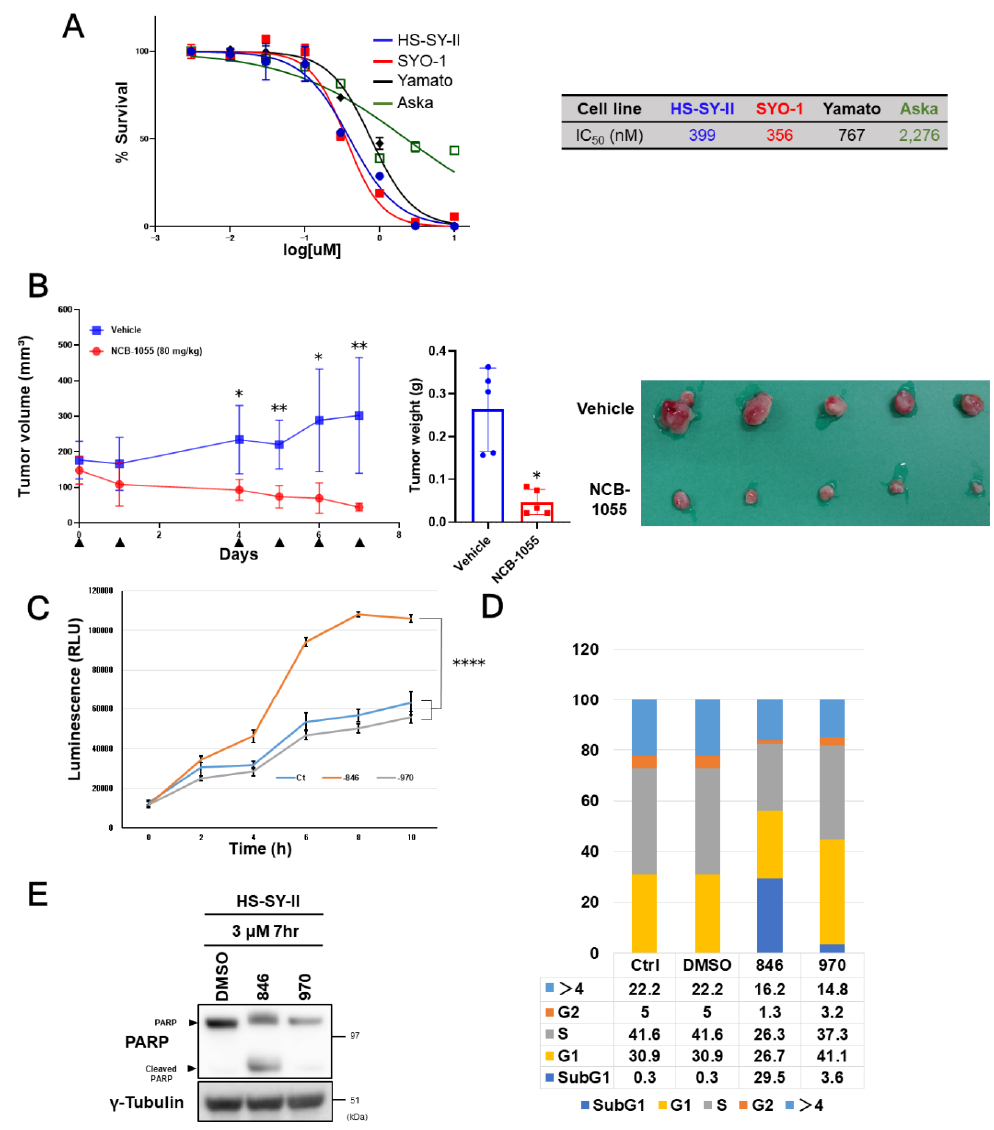
Figure 3. Sensitivity of synovial sarcoma to NCB-0846. ( A ) ATP production by four synovial sarcoma cell lines cultured with increasing doses of NCB-0846 for 72 h. Data represent the mean (relative to no treatment) of three replicates. ( B ) HS-SY-II cells were inoculated into the subcutaneous tissues of 6 week old female NOD.CB17- Prkdc scid /J (NOD/SCID) mice. When the average volume of the